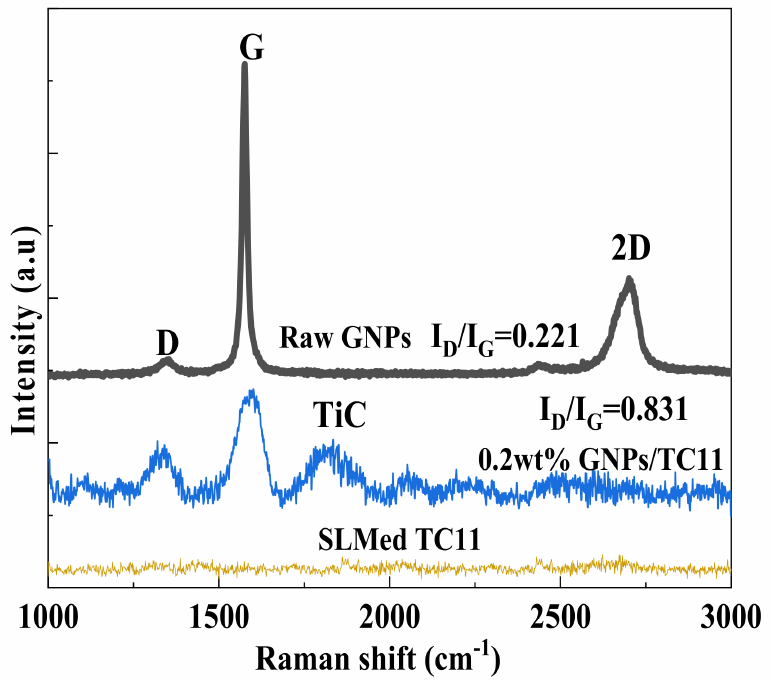
Figure 1. XRD patterns: ( a ) TC11 alloys and titanium matrix composite and ( b ) a partial view of ( a ).